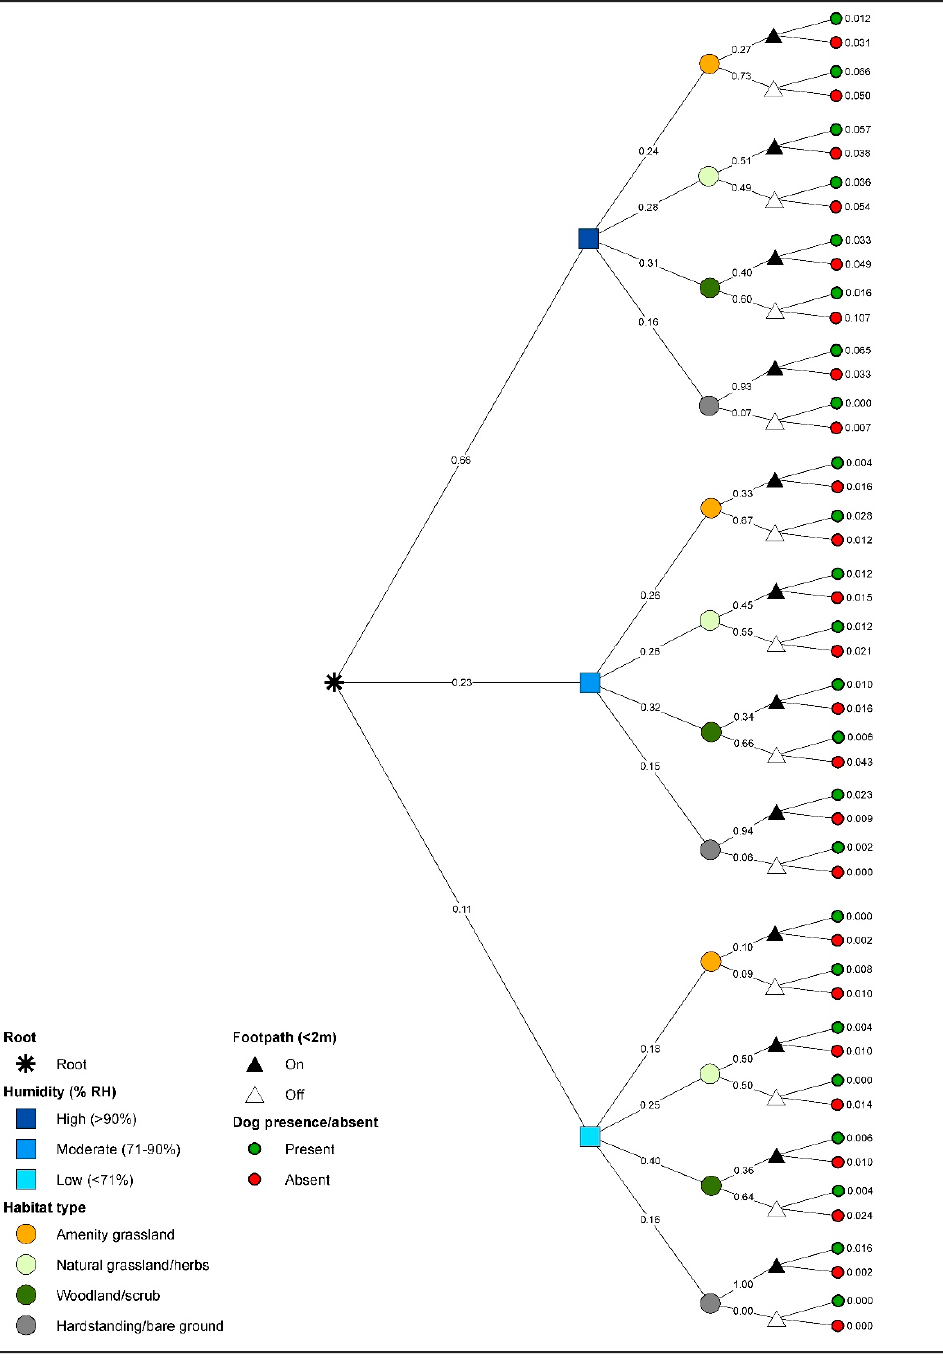
Figure 2. Example of conditional probability tree for determining differences between likelihood of encounter, in this case for the presence/absence of dogs ( Canis lupus familiaris ) across 7 sites in Brighton and Hove and surrounding areas, England, UK.